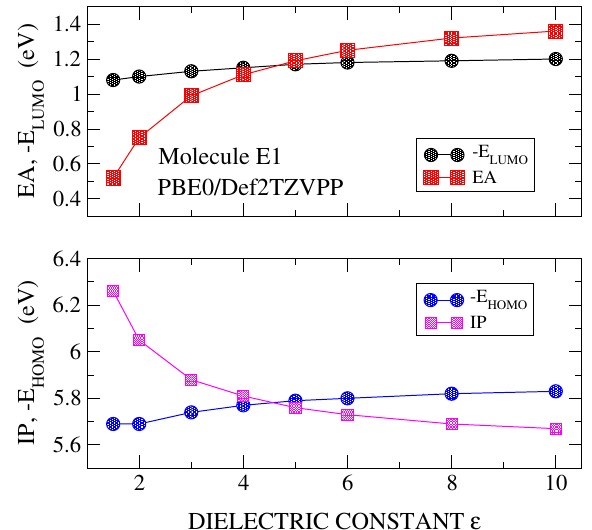
Figure 3. Calculated values of IP and E HOMO ( lower panel ) and EA and E LUMO ( upper panel ) for molecule E1. Calculations were carried out with PBE0/Def2TZVPP method and using PCM with a dielectric constant ε varying in the range